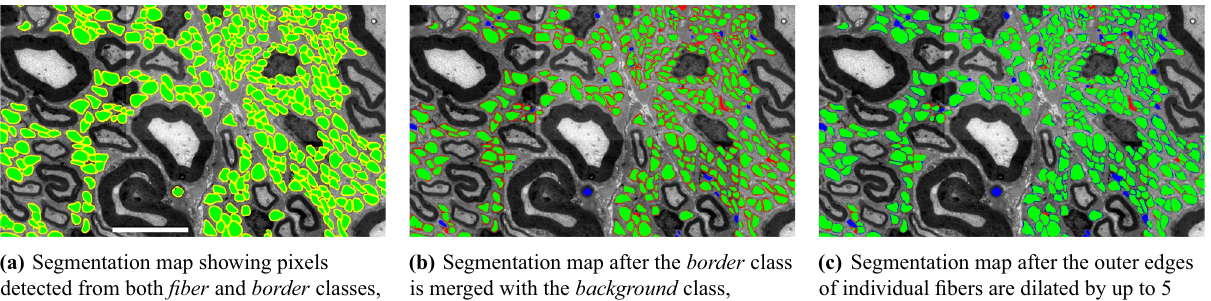
Figure 6. Illustration of the post-processing. Green is used for pixels assigned to the fiber class, yellow for those assigned to the border class, red false negatives, and blue false positives. Scale bar: 6 µ